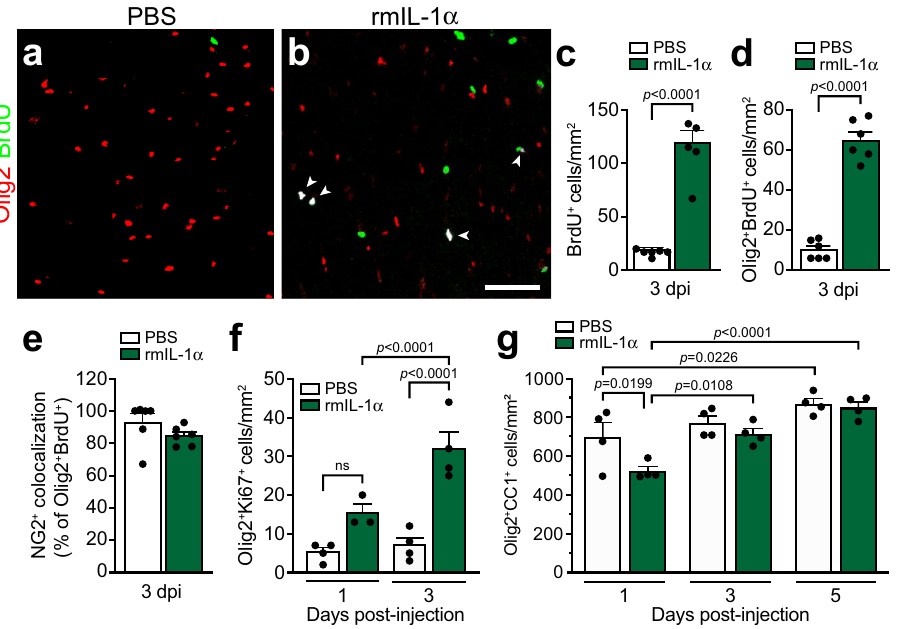
Fig. 3 | Proliferating oligodendrocyte precursor cells rapidly restore the number of mature oligodendrocytes in mice injected centrally with IL-1 α . a , b RepresentativeconfocalimagesshowingOlig2(red)andBrdU(amarkerofcell proliferation, green) immunostainings in the spinal cord white matter of C57BL/6 mice injected with either PBS ( a ) or rmIL-1 α ( b ) at 3 days post-injection. White arrowheads indicate certain proliferating oligodendrocyte lineage cells. c , d Quanti fi cation of the total number of BrdU + cells ( c ) and Olig2 + BrdU + double- positive cells ( d ) in the spinal cord white matter at 3 days post-injection of PBS or rmIL-1 α intra-cisterna magna (i.c.m.) ( n =6 mice/group). e Percentage of Olig2 + BrdU + cellscoexpressingthe NG2marker,anindicator of OPCs ( n =6 mice/group).